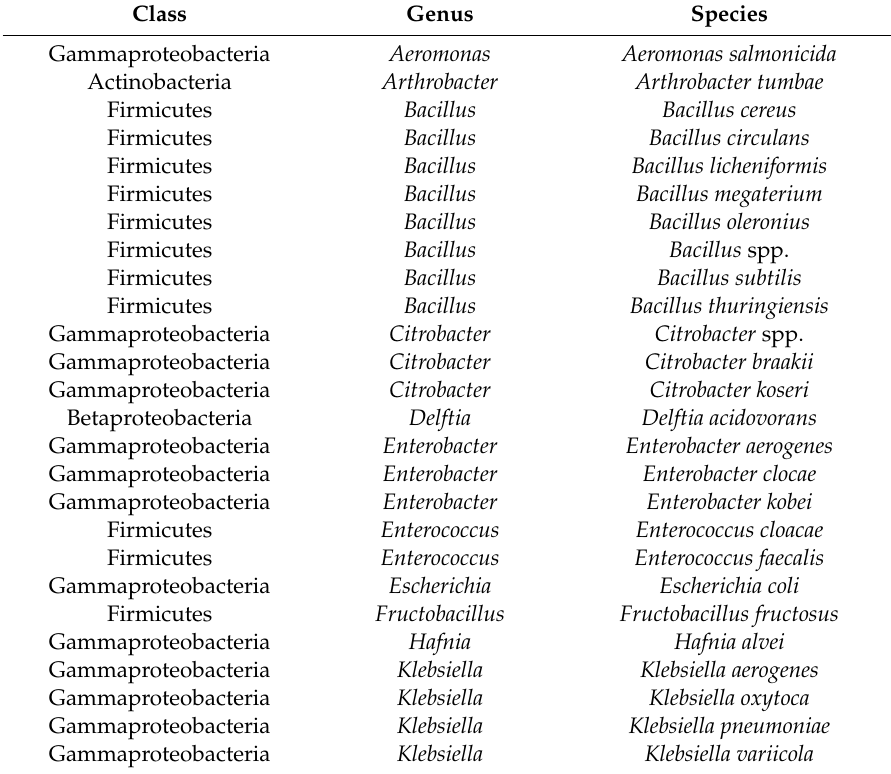
Table 2. Isolated species of adult worker honeybee bacteriota from gastrointestinal